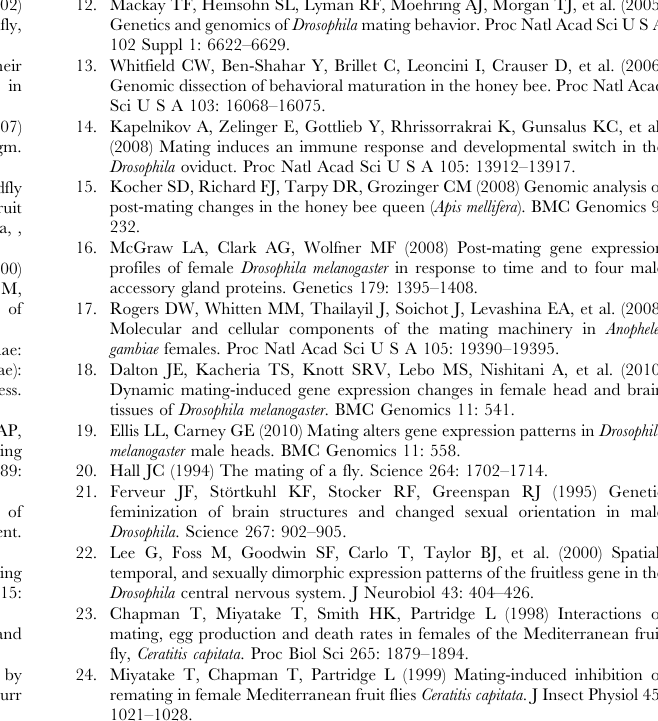
Table S4 Transcripts that change in abundance in mature virgin males compared to immature virgin males. Table S5 Significantly enriched biological process gene ontology annotations among transcripts that showed changes in abundance in mature virgin male heads compared to immature male heads. Table S6 Significantly enriched biological process gene ontology annotations among transcripts that showed changes in abundance in mated female heads compared to mature virgin female heads. Table S7 Transcripts that change in abundance in mated males with respect to mature virgin males. Table S8 Significantly enriched biological process gene ontology annotations among transcripts that showed changes in abundance in mated male heads compared to mature virgin male heads. Table S9 Correlation of microarray changes of transcript abundance with real-time qRT-PCR for 12 genes (log 2 trans- formed fold